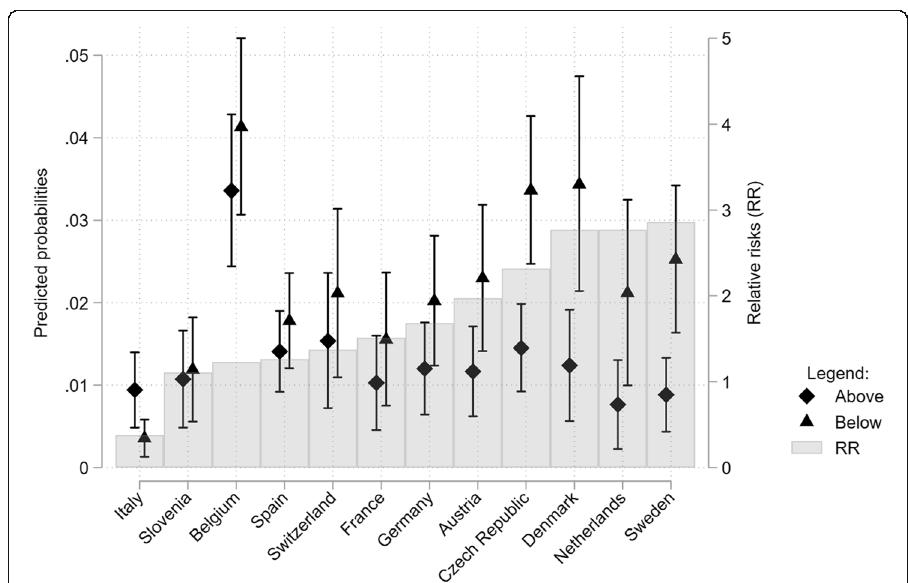
Fig. 8 Predicted probabilities (left axis) and 95% confidence intervals for individuals below the median income (triangles) and above-median equalized income (diamonds) and associate relative risks (RR; bars; right axis) of being in a nursing home by country, controlling for age and health